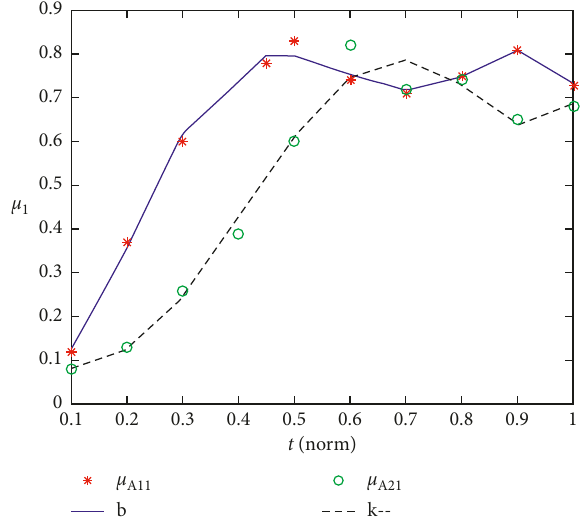
Figure 5: A comparison of μ